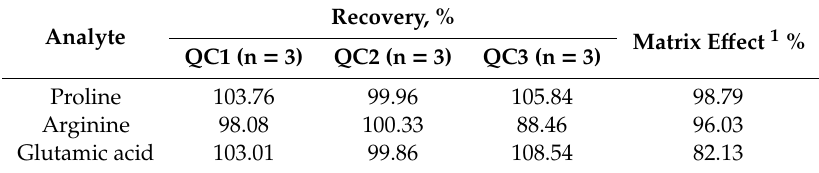
Table 2. Mean percentage recoveries of the target metabolites and the determined matrix e ff